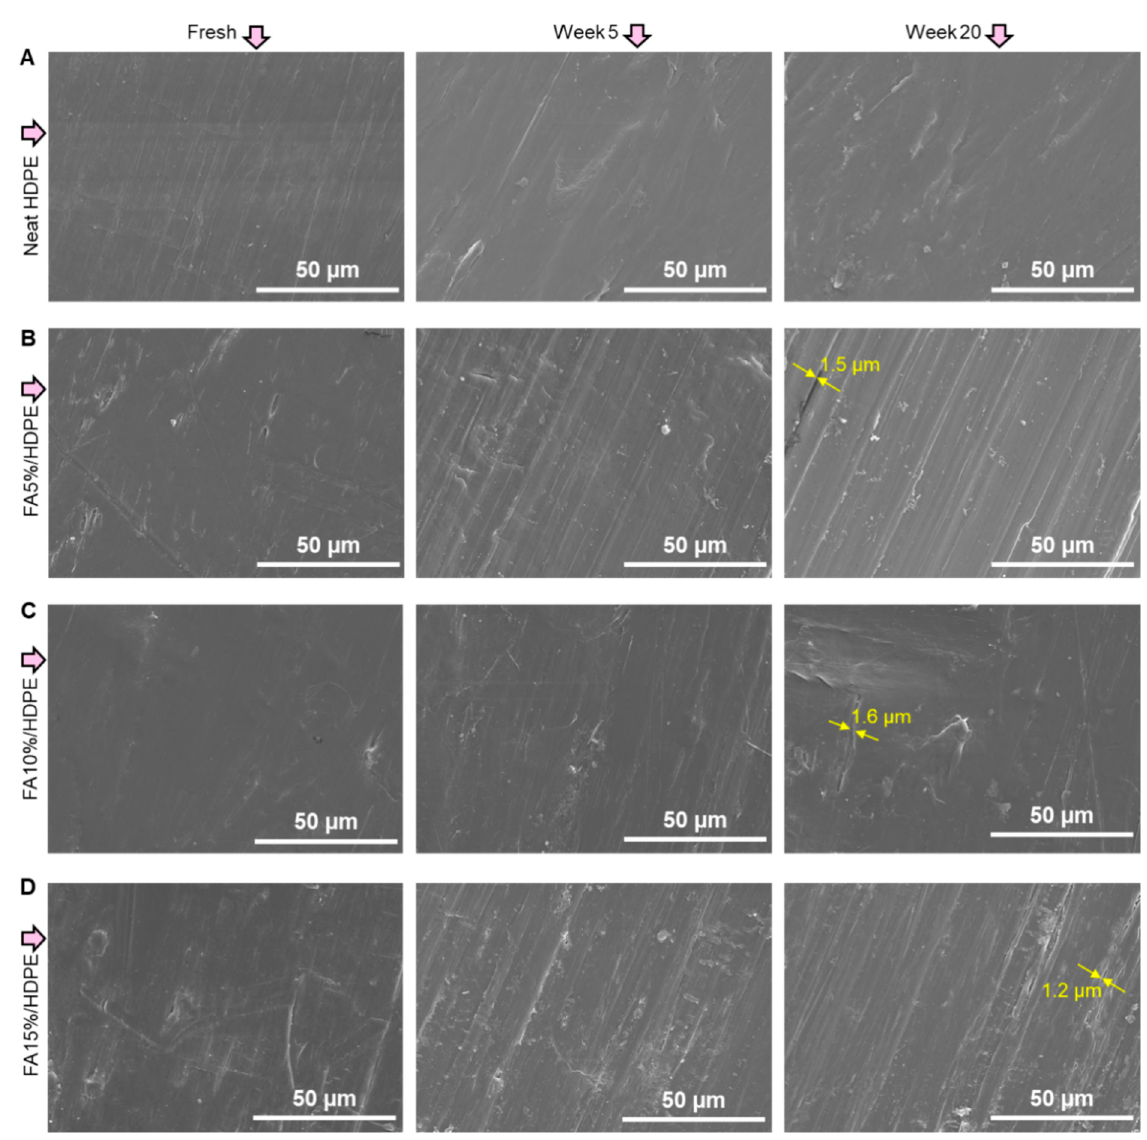
Figure 2. Surface morphology of materials before and after ageing in a QUV chamber: ( A ) neat HDPE, ( B ) FA5%/HDPE, ( C ) FA10%/HDPE, ( D ) FA15%/HDPE. (Arrows point to the minimum cracks initiated after 20 weeks of ageing).